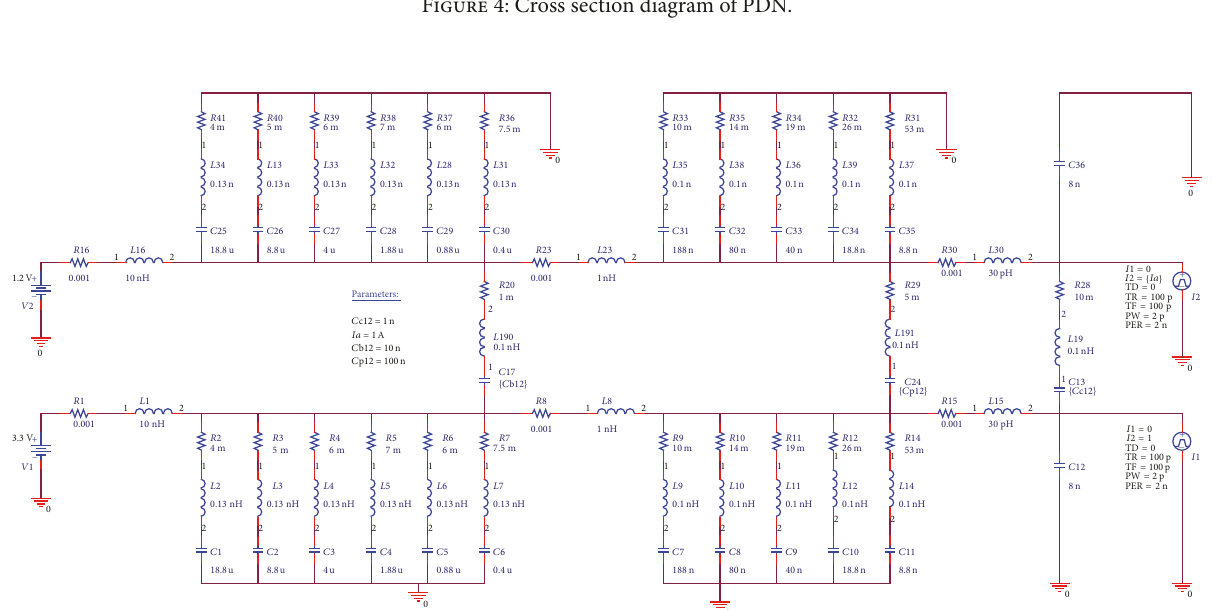
Figure 5: Lumped circuit of the PDN with dual supply voltages and two cores without circuit